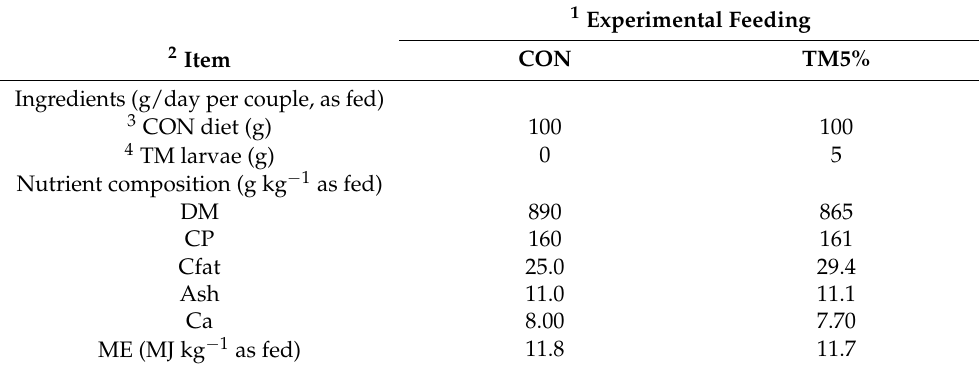
Table 1. Feeding plan and diets fed to partridge couples according to experimental groups (CON vs. TM5%). Nutrient composition is reported on an as-fed basis (g/kg